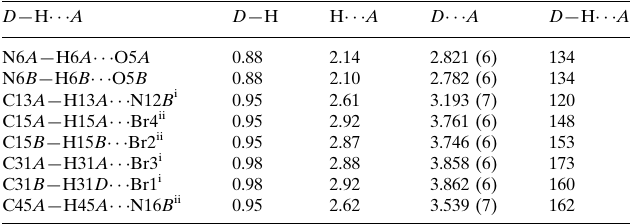
Hydrogen-bond geometry (A˚ , (cid:1)